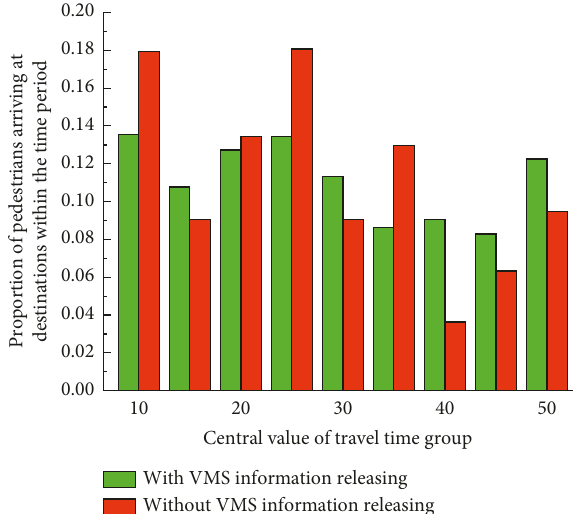
Figure 18: Travel time distribution of pedestrians for the scenario of egress.